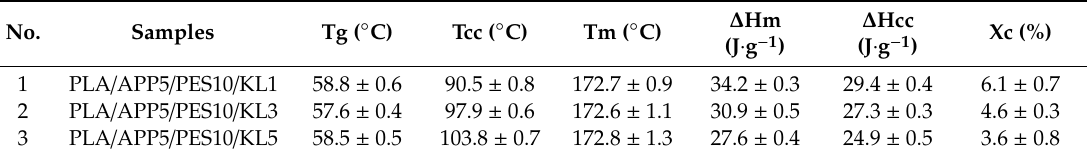
Table 7. Thermal properties of bicomponent fibers by DSC